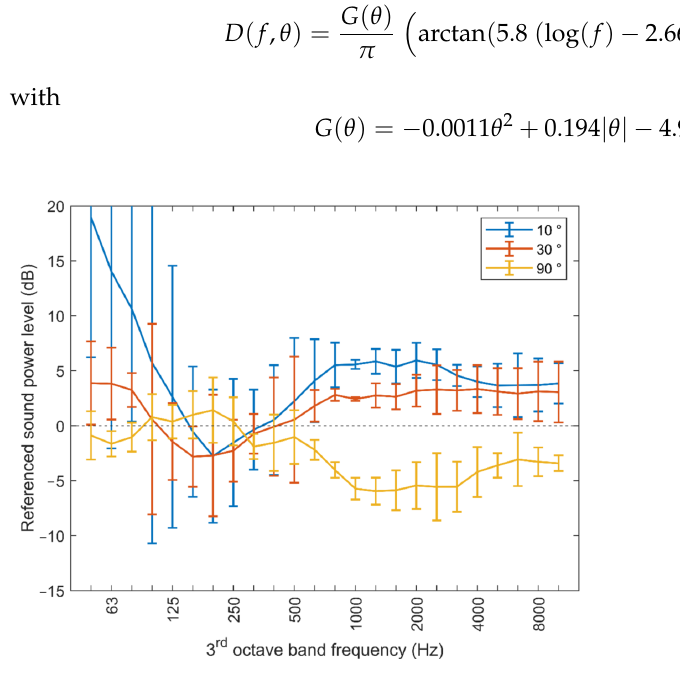
Figure 10. Averaged directivity pattern with the bars showing the variation among the three multi- copters under evaluation. Note: The averaged directivity pattern is shown for three radiation angles with the spectrum at a radiation angle of 60° used as reference.